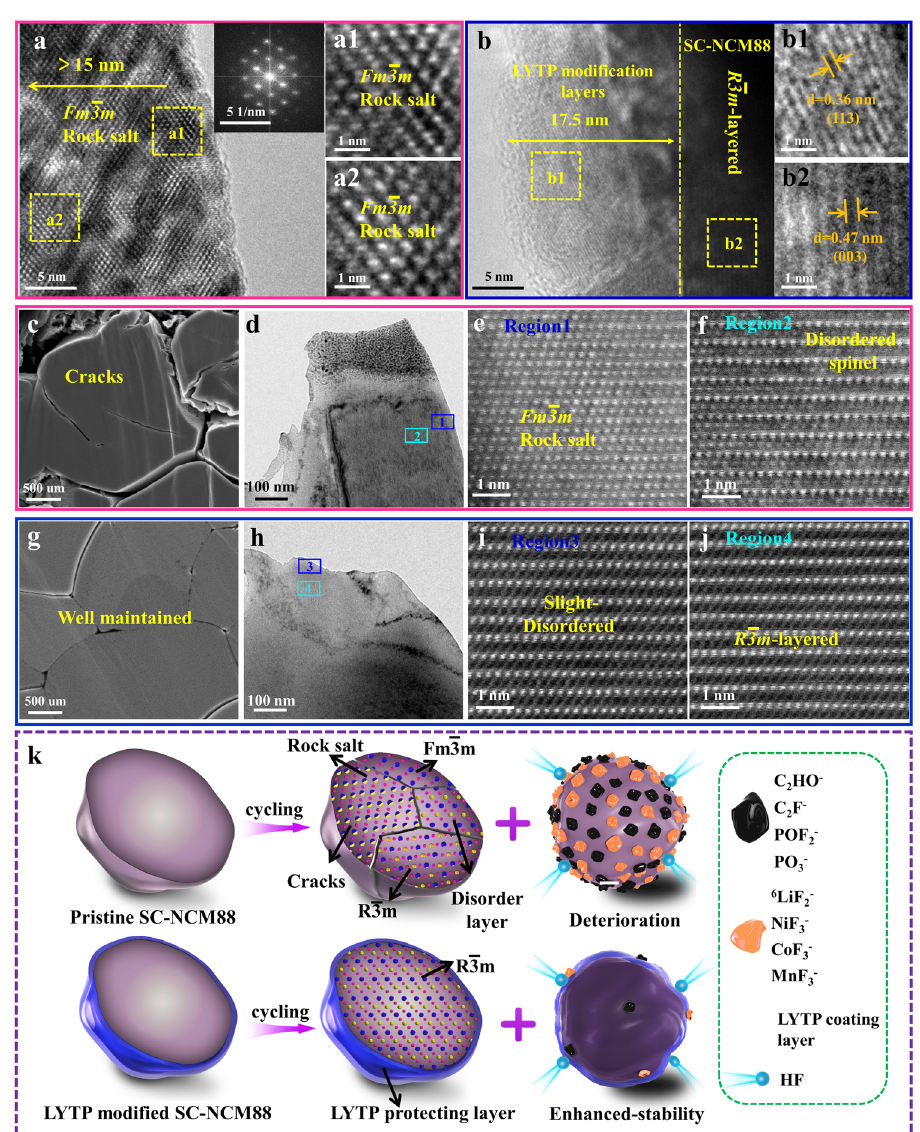
Fig. 9 Intraparticle structural evolution after pouch cell long-term cycling. Post-mortem HRTEM and magni fi ed HRTEM at selected area images for ( a , a1 , a2 ) pristine SC-NCM88 and ( b , b1 , b2 ) 1% LYTP@SC-NCM88 after 200 cycles. Cross-sectional SEM images of ( c ) pristine SC-NCM88 and ( g ) 1% LYTP@SC-NCM88. Low-magni fi cation HAADF-STEM image of FIB-cross-section for the surface region and magni fi ed HAADF-STEM images taken from the corresponding surface areas for ( d – f ) pristine SC-NCM88 and ( h – j ) 1%LYTP@SC-NCM88 after 200 cycles. k Schematic illustration of the structure evolution and internal crack difference for pristine SC-NCM88 and 1% LYTP@SC-NCM88 particles during prolonged